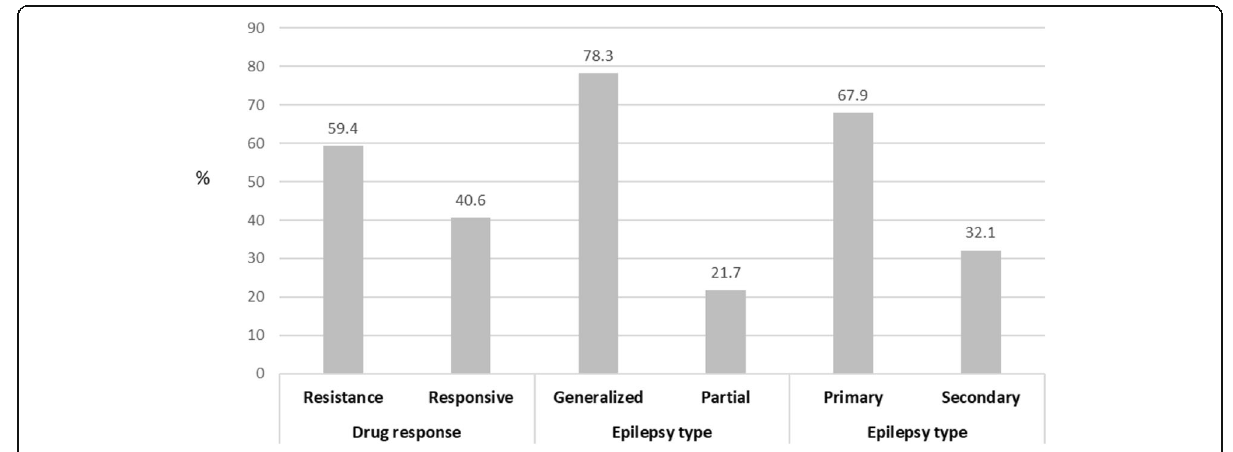
Fig. 2 Epilepsy type and drug response among the studied